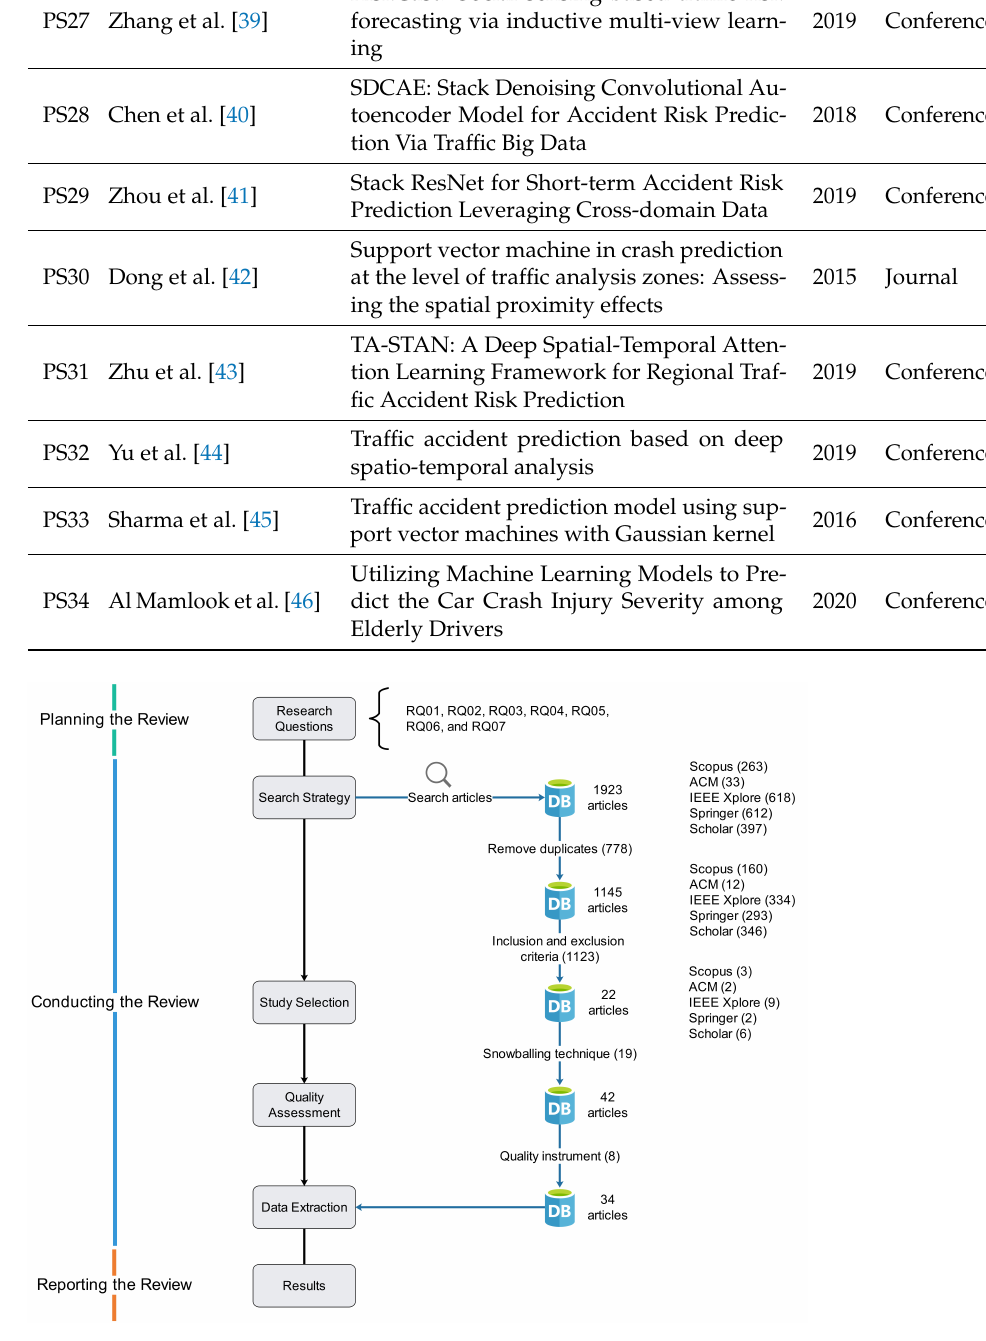
Figure 1. The review